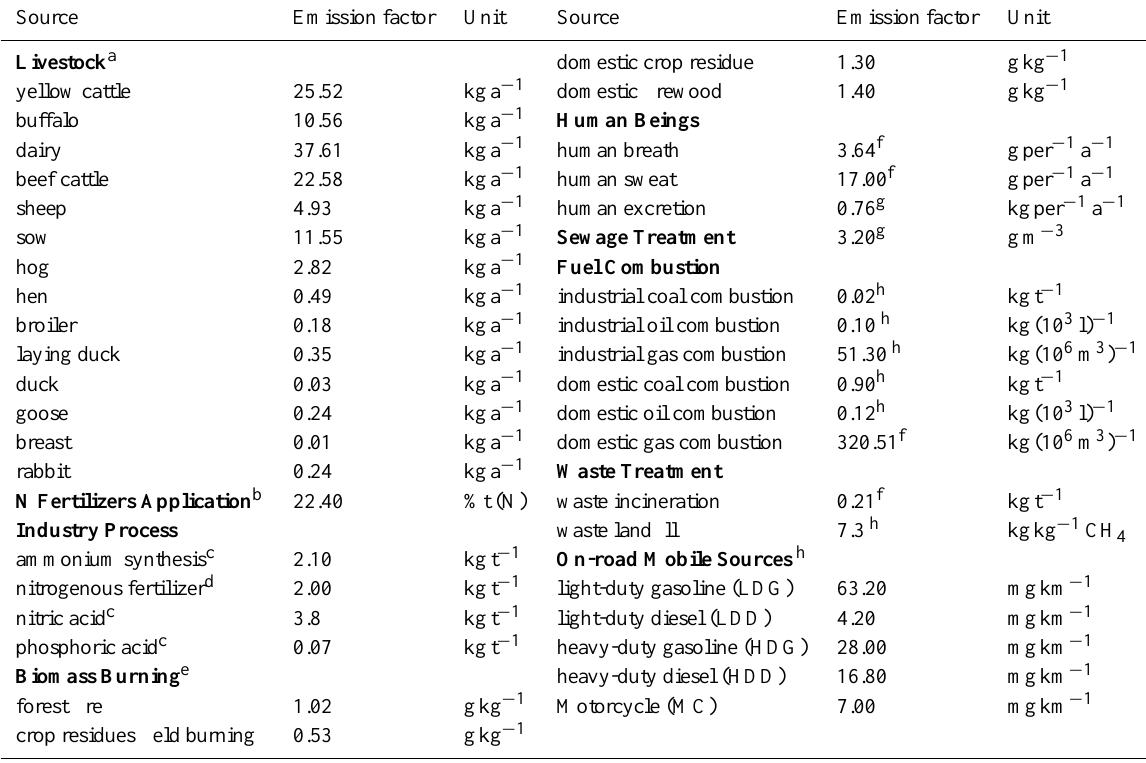
Table 3. Emission factors used in this study (as: NH 3 )